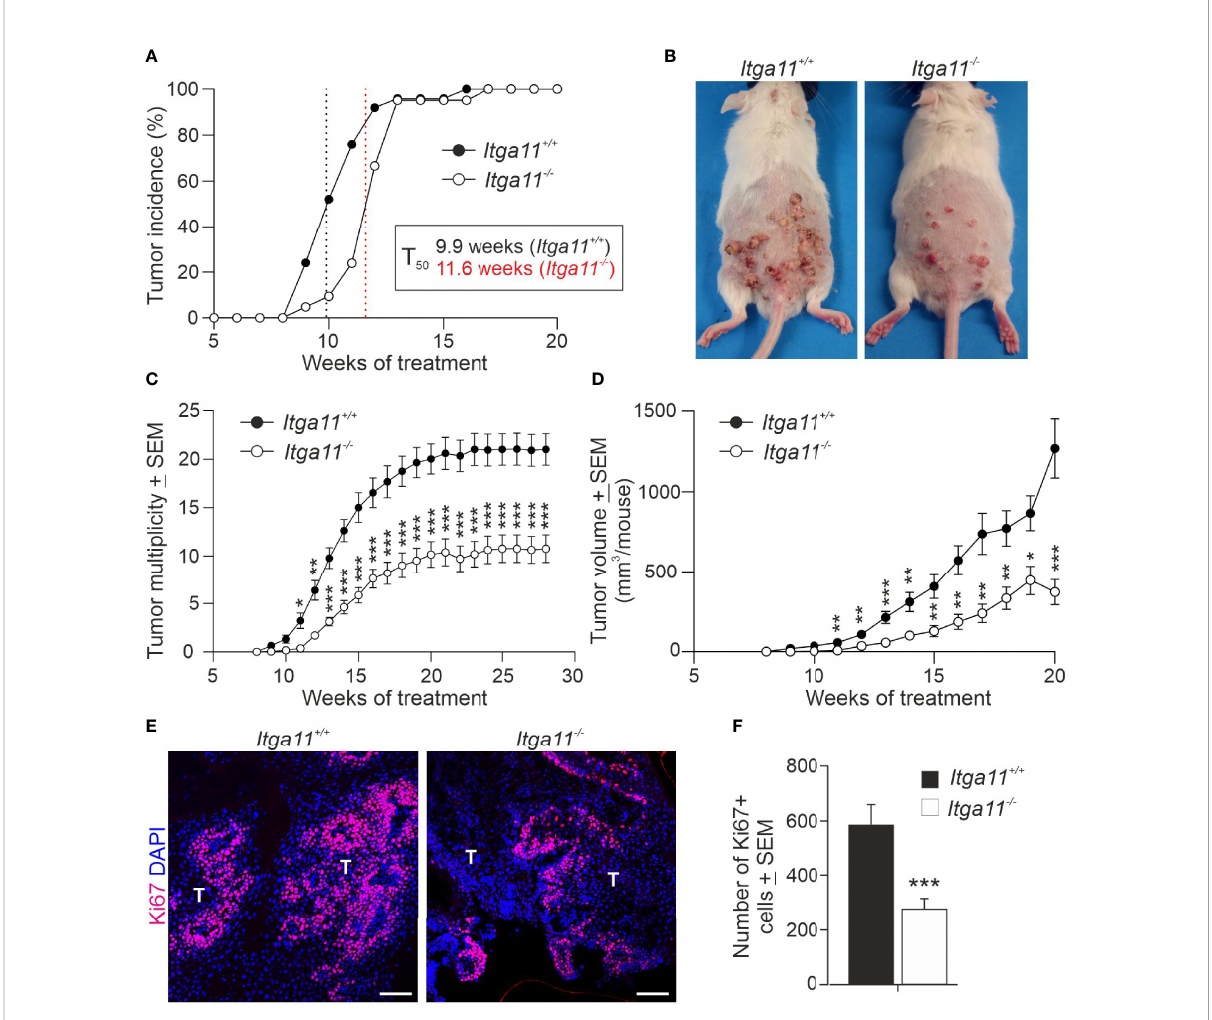
FIGURE 3 Skin tumor growth is impaired in integrin a 11-de fi cient mice. Tumors were induced in the dorsal skin of the Itga11 +/+ (n = 25) and Itga11 -/- (n = 21) male mice using the 7,12-dimethylbenz[a]anthracene (DMBA)/12-O-tetradecanoylphorbol-13-acetate (TPA) protocol, and tumor incidence and multiplicity were monitored for up to 28 weeks in some individuals. (A) Tumor incidence. At week 10, the tumor incidence in the Itga11 -/- mice was approximately 50% that in the Itga11 +/+ mice. There was a delay of two weeks in terms of tumor incidence in the Itga11 -/- mice (T 50 ); however, all mice developed skin tumors by week 13. (B) Representative photographs of the DMBA/TPA-treated Itga11 +/+ and Itga11 -/- mice at week 20. (C) Cumulative tumor multiplicity. Compared to the Itga11 +/+ controls, the Itga11 -/- mice developed roughly 50% fewer skin tumors upon DMBA and TPA treatments. (D) The total tumor burden per mouse was signi fi cantly smaller in the Itga11 -/- mice from week 10 onwards. (E, F) Tumor cell proliferation. Representative images of Ki67 staining of the control and a 11-de fi cient skin papillomas and quanti fi cation of proliferating Ki67-positive cells. Ten papillomas per genotype (from different mice) and four to fi ve microscopic fi elds for each papilloma sample at a magni fi cation of 200× were counted. In E, scale bars 100 m m; T, tumor. *, p<0.05, **, p<0.01, ***,